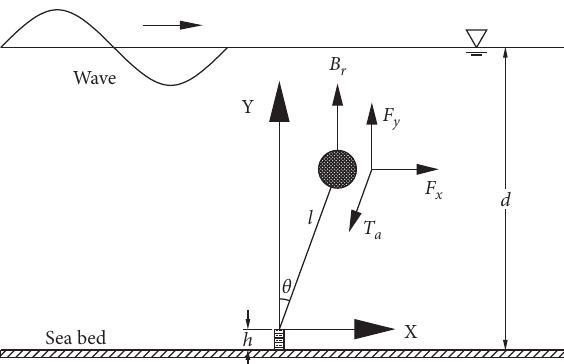
Figure 2: Simplified model of